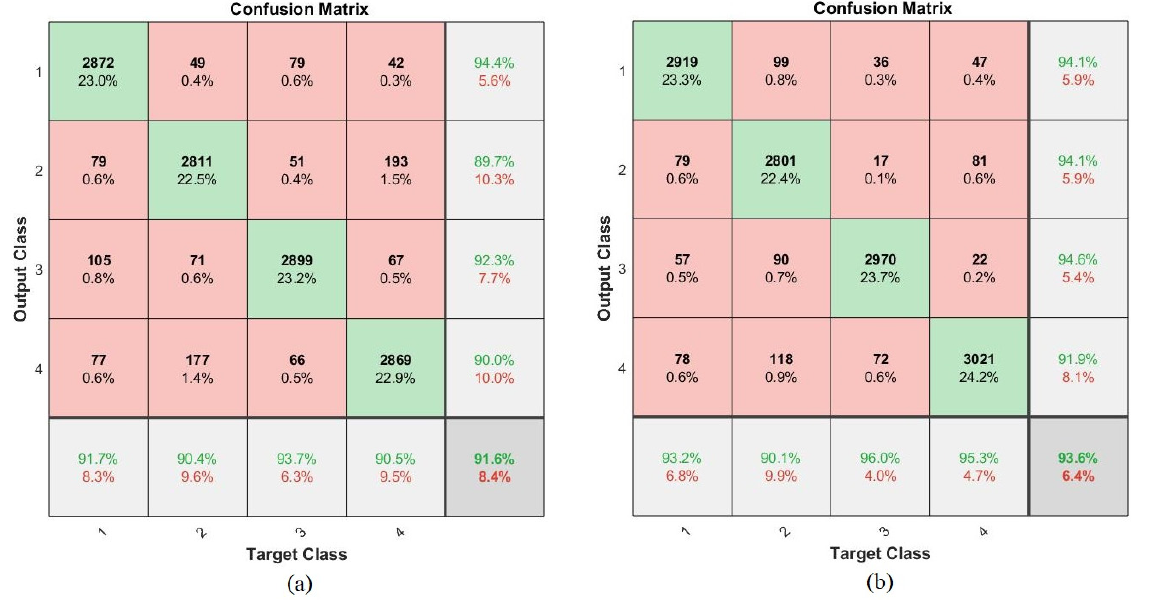
Figure 13. Confusion matrix of microscopic blood sample dataset produced using the ( a ) ANN algorithm and ( b ) FFNN algorithm. Table 2. The performance of ANN and FFNN used on the microscopic blood samples